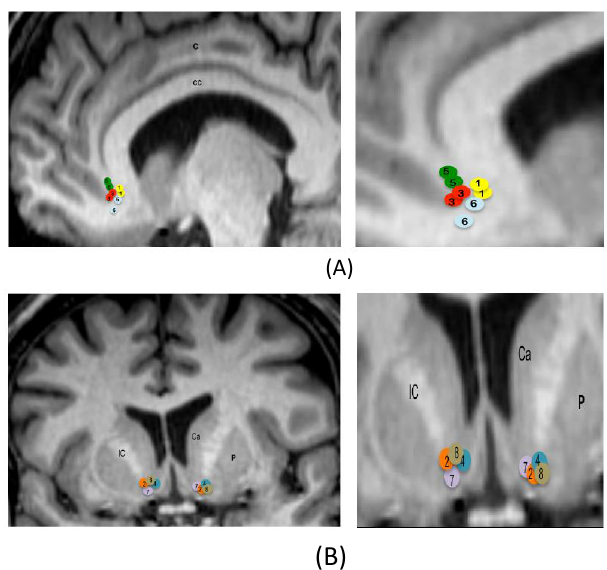
Figure 2. Location of electrode active contacts. ( A ) Location of electrode contacts on a sagittal view for patients with DBS on the subcallosal cingulate. Circles are schematic representations of electrode active contacts. Numbers within circles correspond to each patient. The figure at the right side is an enlargement. C = cingulate. CC = corpus callosum. ( B ) Location of electrode contacts on a coronal view for patients with DBS on the nucleus accumbens. Circles are schematic representations of electrode active contacts. Numbers within circles correspond to each patient. The figure at the right side is an enlargement. CA = caudate nucleus. CI = internal capsule. P = putamen. DBS = deep brain stimulation.